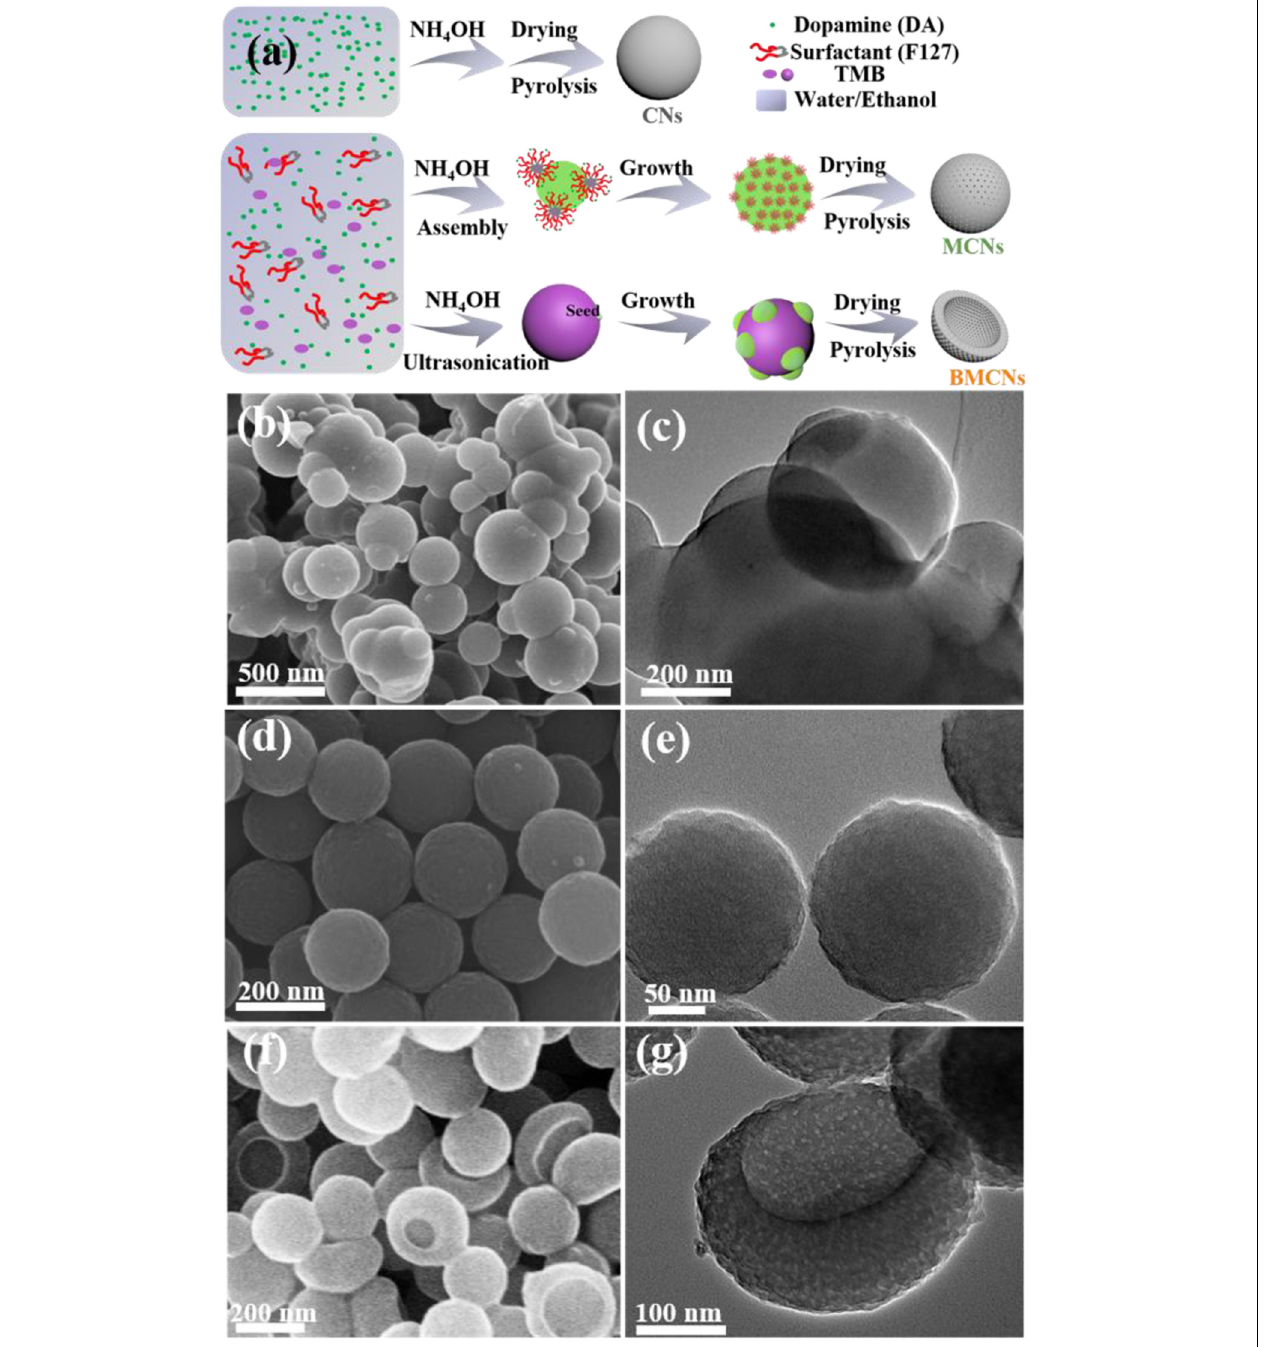
FIGURE 1 | (a) Schematic illustration for the fabrication procedure of CNs, MCNs, and BMCNs. FESEM and TEM images of (b–c) CNs, (d–e) MCNs, and (f–g) BMCNs.